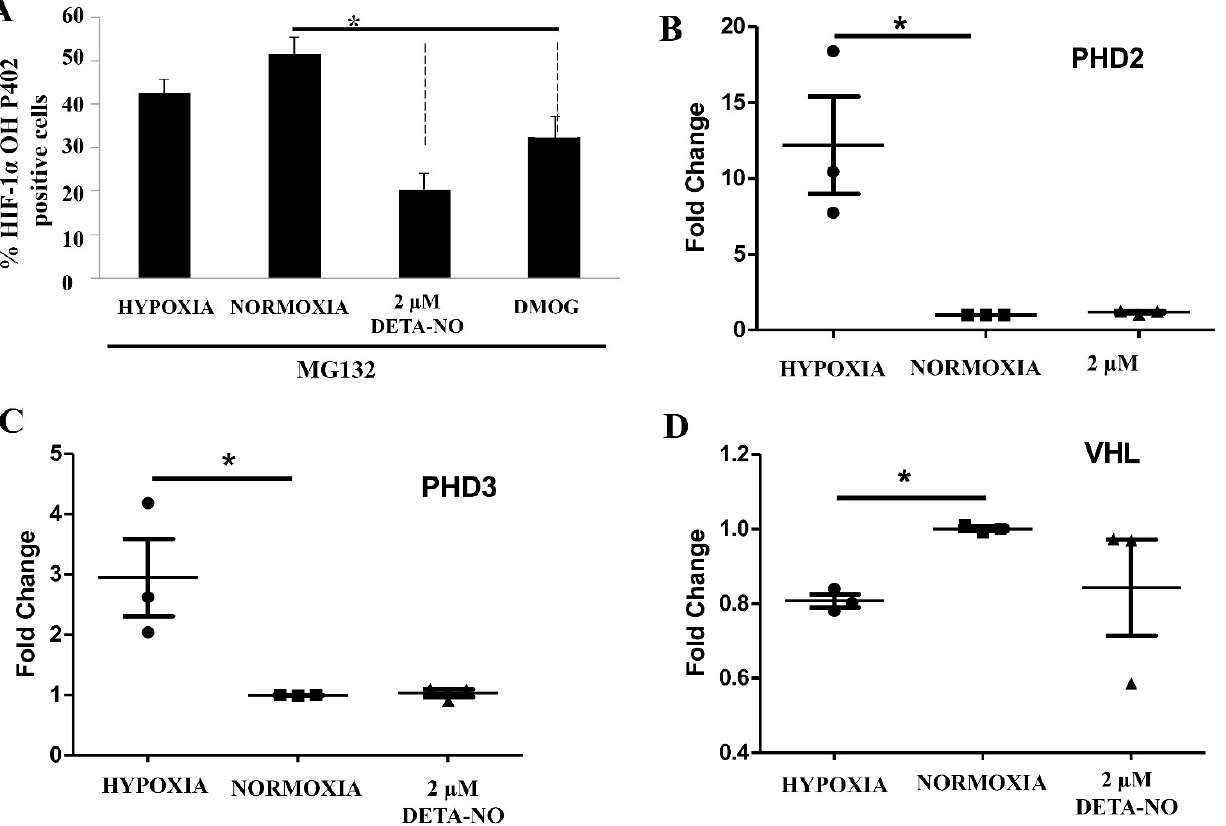
Figure 7. Effect of treatment with 2 µ M DETA-NO on HIF stability regulators. ( A ) Quantification by flow cytometry of HIF-1 α hydroxylation. MSUH001 cells were cultured for 6 days in a conditioned medium in the presence of bFGF and subsequently exposed to 5% of O 2 for 48 h. In another set of experiments, cells were cultured under normoxia (20% O 2 ) and 2 µ M DETA-NO for 48h. Exposure to DMOG (1 mM) for 4 h under normoxia was studied as a positive control. To halt the degradation of hydroxylated HIF-1 α , the proteasome inhibitor MG132 (10 µ M) was added 4 h before the end of the experiment. The bar graph shows the percentage of HIF-1 α OH P402 ± SEM positive cells from 3 independent experiments. ( B , C ) Analysis of mRNA expression of prolyl hydroxylases 2 and 3 (PHD2, PHD3). The graph shows the mean of the relative expression of 4 independent experiments ± SEM. ( D ) mRNA expression levels of the Von Hippel–Lindau (VHL) gene. The plot shows the mean of the relative expression of 3 independent experiments ± SEM. The relative expres- sion of genes was calculated with the algorithm ∆∆ Ct. Values were relativized to the expression of the β -actin gene, and values were relativized to normoxia condition. (*) p < 0.05; (**) p < 0.005; HIF-1 α OH P402 (HIF-1 α hydroxylated at the proline residue P402).